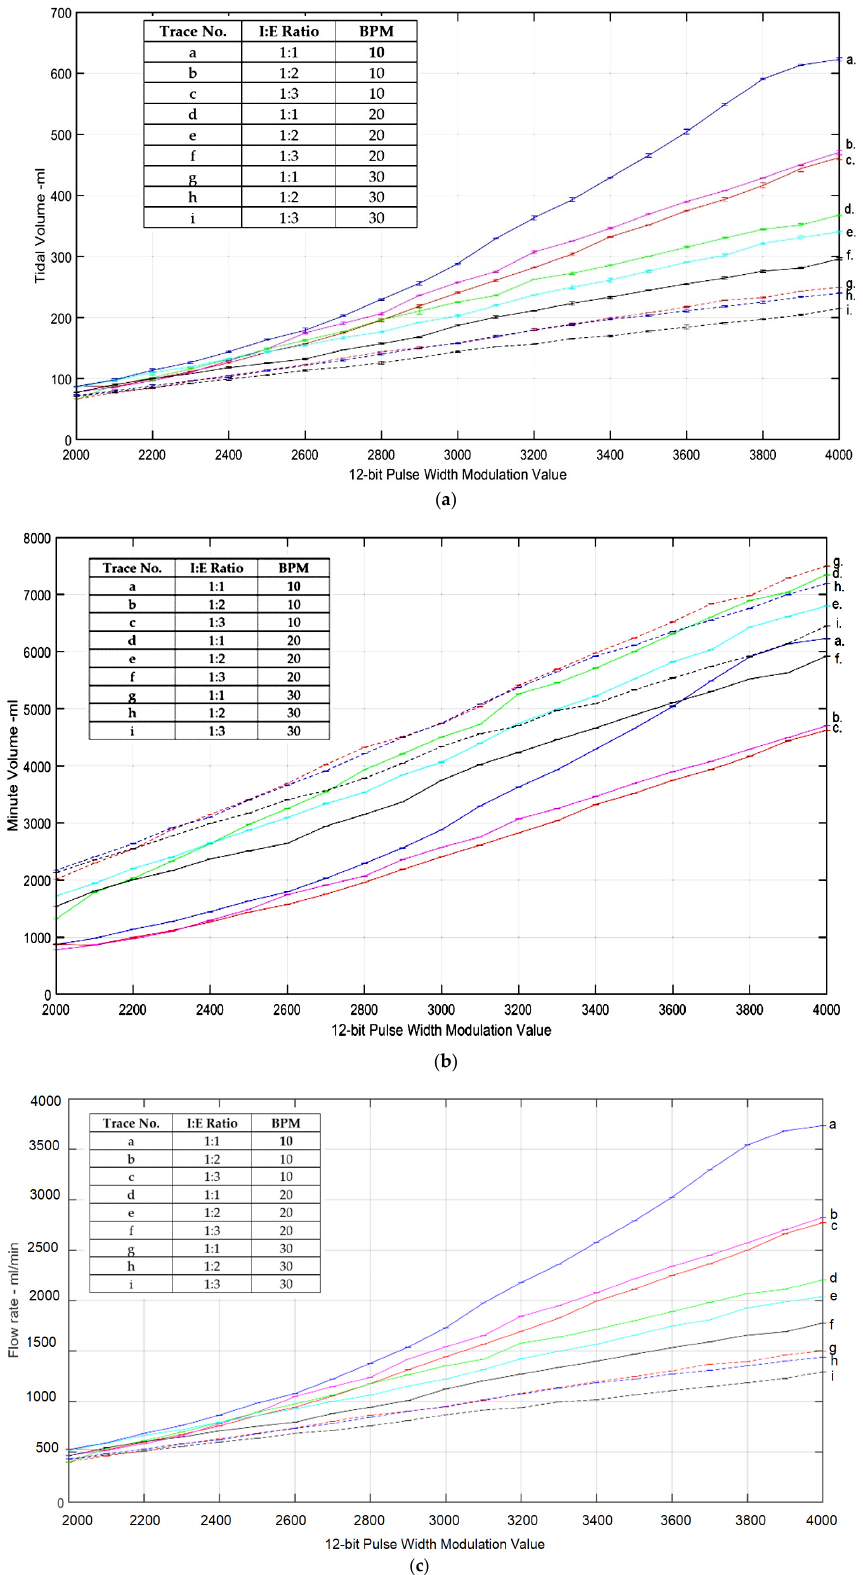
Figure 17. ( a ) Graph of PWM-tidal volume, ( b ) graph of PWM-minute volume, and ( c ) graph of PWM-flowrate . The graphs demonstrate a non-linear relation and, hence, require cubic polynomial curve fitting.